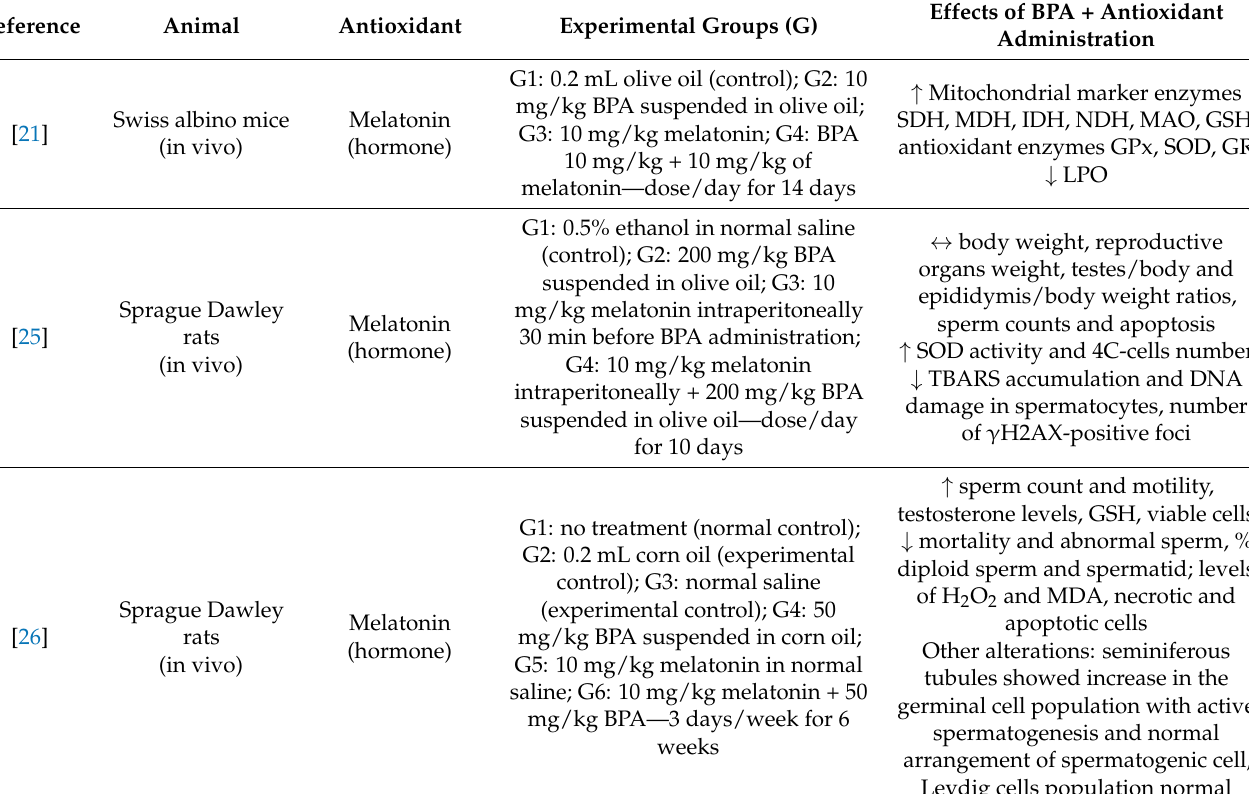
Table 1. Antioxidants used to treat or prevent BPA-induced male fertility and their effects. The animal model used in each study, the experimental design, and the effects of the coadministration of BPA and antioxidant compared with the effects of BPA exposure alone were also